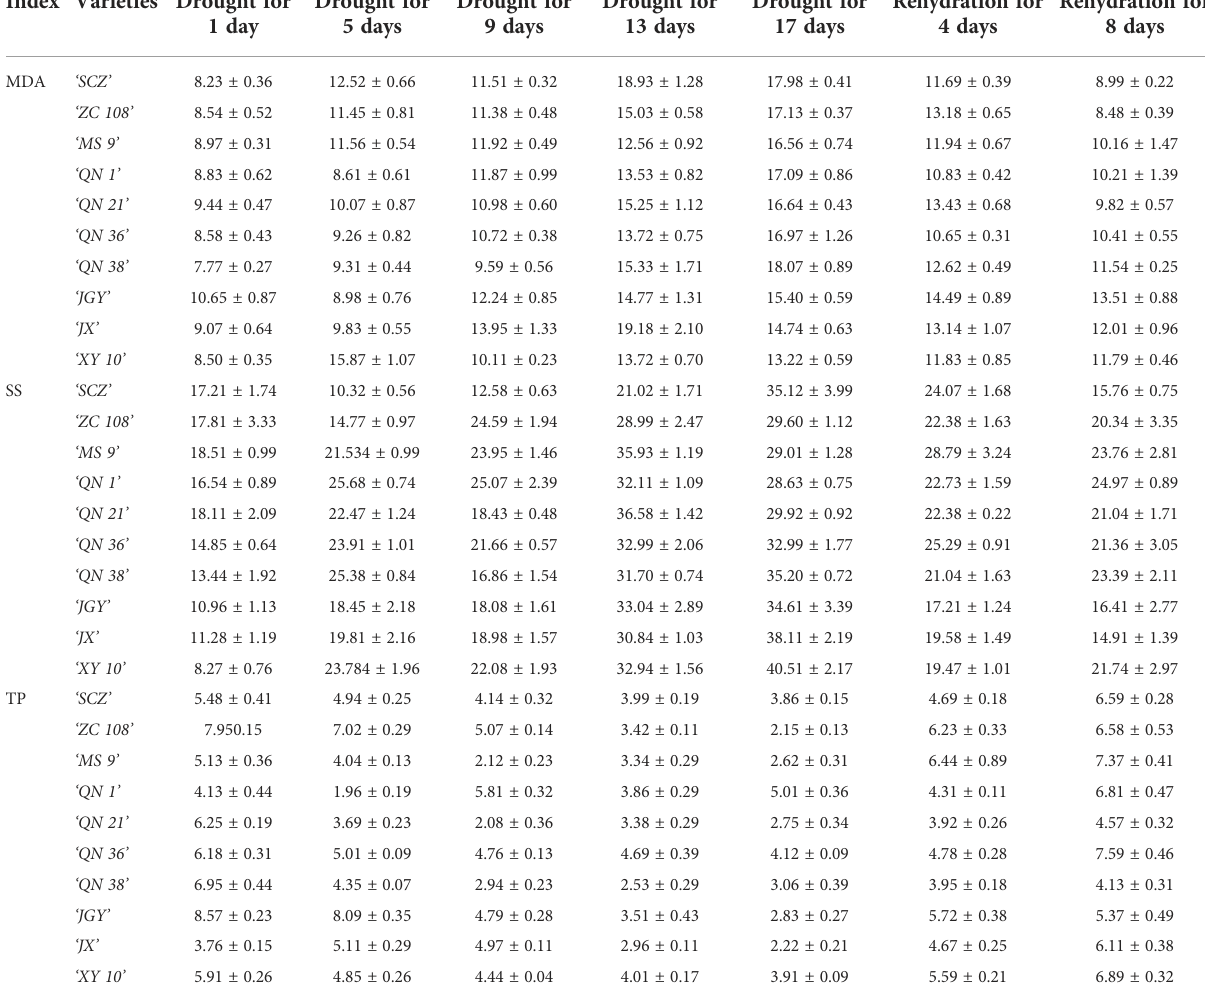
The data in the table are the mean of three repetitions ± standard error of